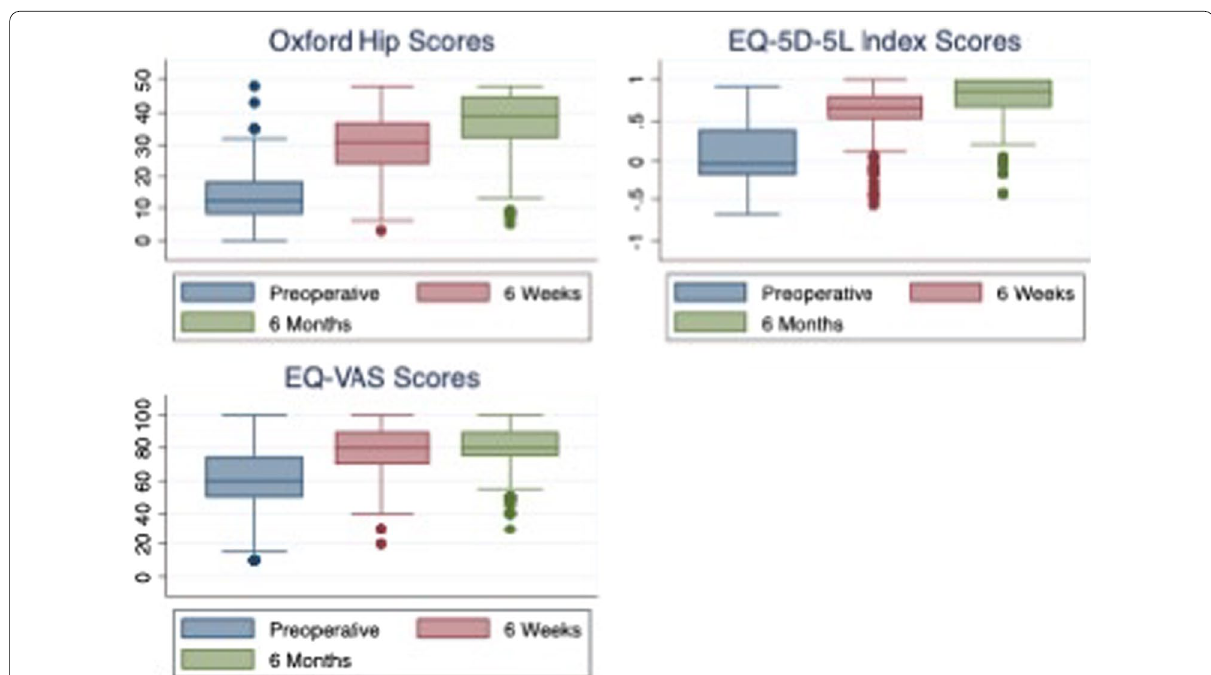
Fig. 1 Boxplots showing distribution of PROMs scores over